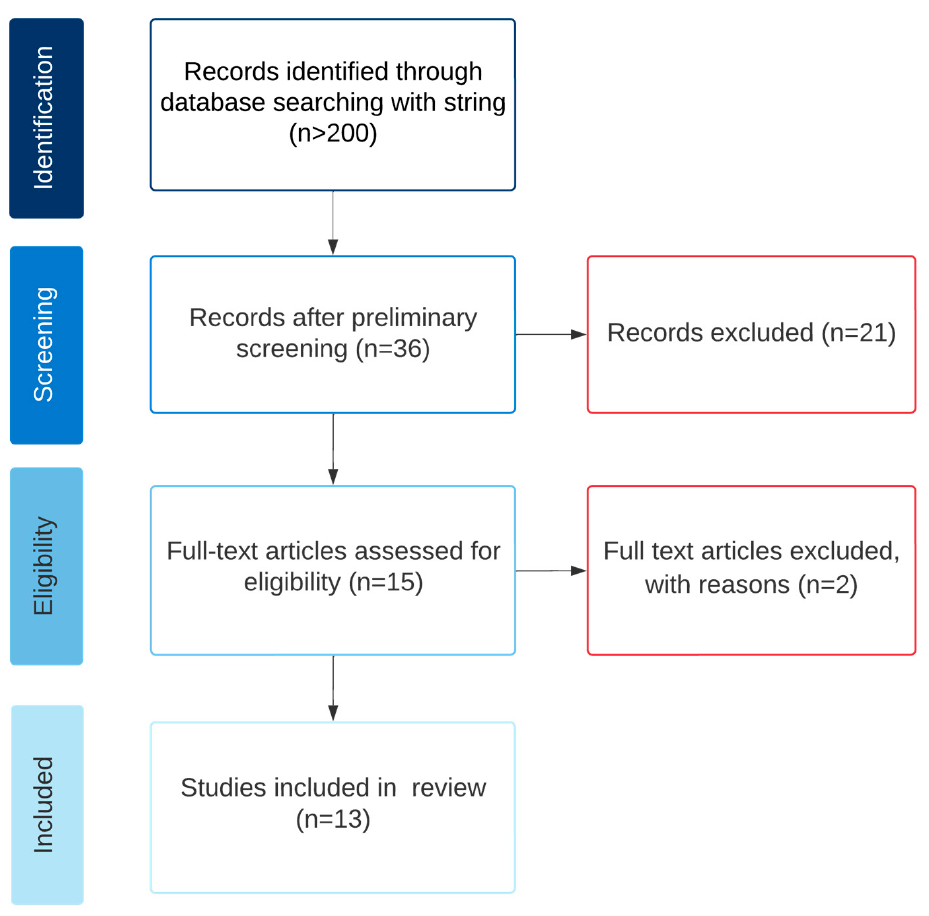
Figure 3. Flowchart of article selection.